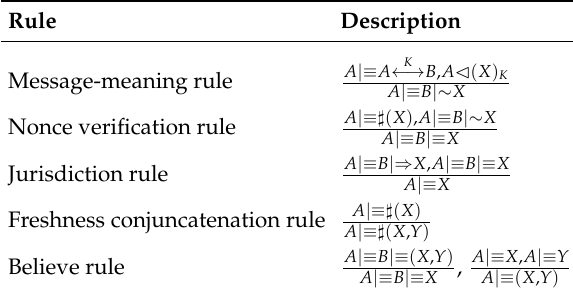
Table 3. Basic BAN-Logic